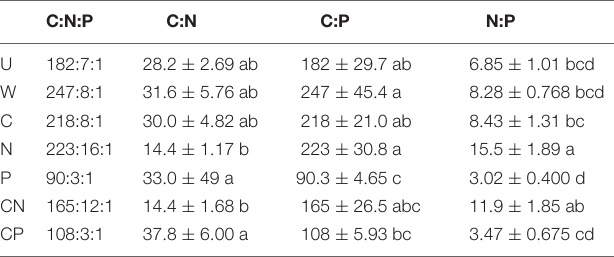
TABLE 1 | Molar C:N:P ratios of soils following 6 years of six resource additions in Fryxell lake basin of the Taylor Valleys in